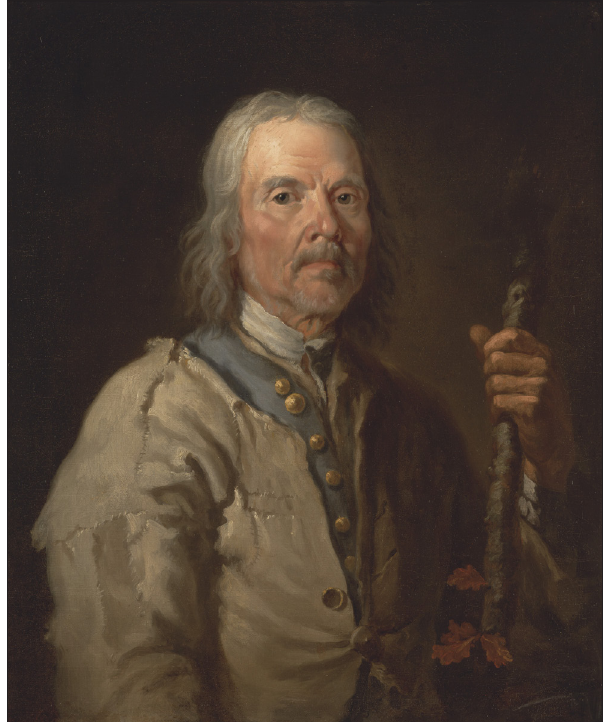
Fig. 2 : Thomas Barker, Man Holding a Staff , c . 1800, oil on canvas, 76.2 × 63.2 cm, Yale Center for British Art, Paul Mellon